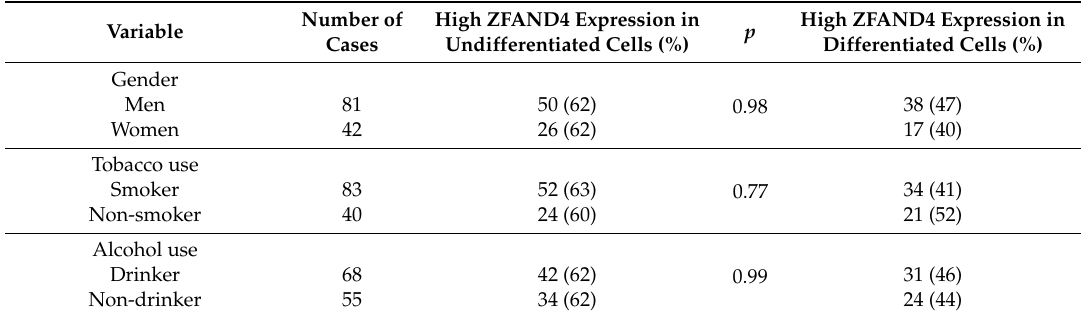
Table 2. Relationships between clinical and pathological variables and high ZFAND4 expression determined by using the maximum value of stained cells to calculate the Allred